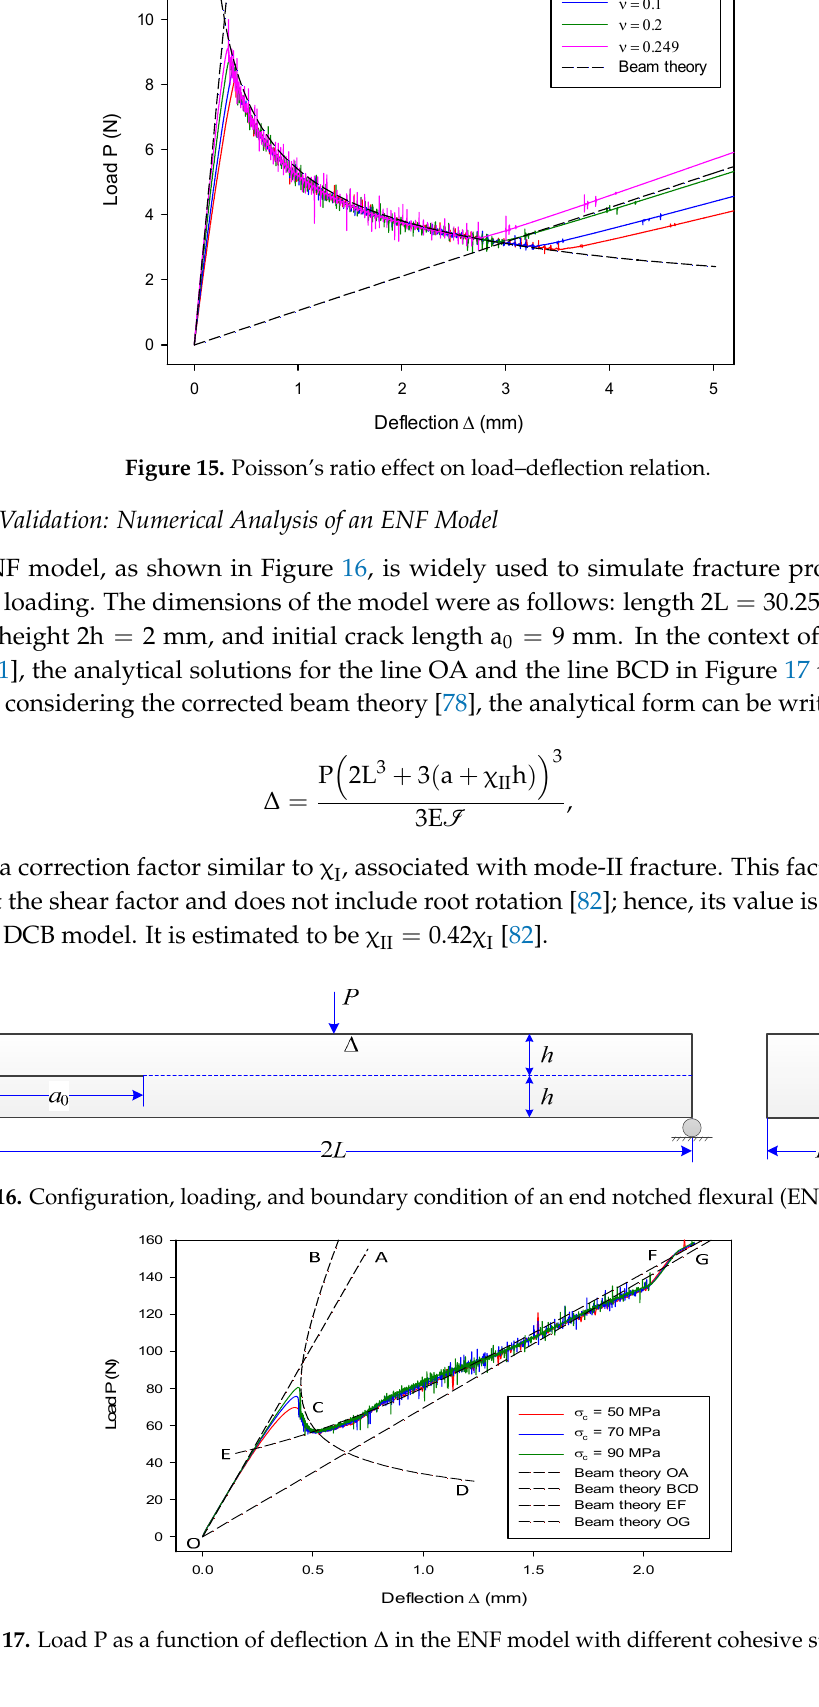
Figure 18. Deformed configuration of the ENF model at t (cid:3404) 30 ms.